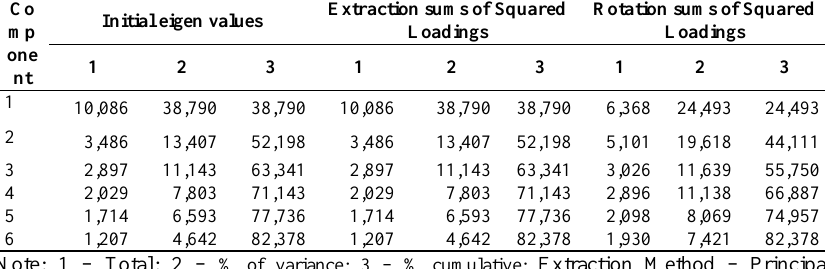
Table 1. Components loadings for QPF